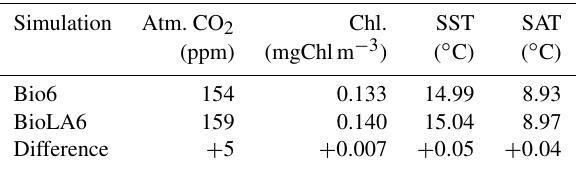
Table B1. Values of the most important climate quantities for the simulations with six phyto- and six zooplankton size classes. The third row represents the differences between the simulation with mi- nus the simulation without phytoplankton light absorption.